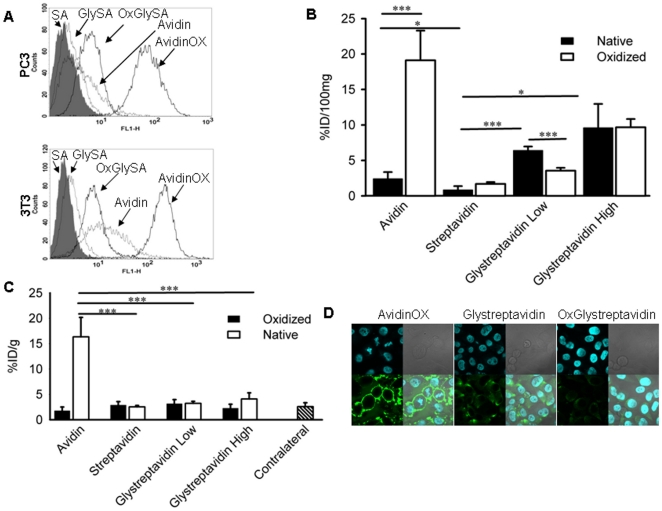

In vitro cell binding, in vivo tissue residence and biotin uptake of chemically glycosylated and oxidized streptavidin.
A, Binding of streptavidin (SA), low mannose streptavidin (GlySA) and oxidized derivative (OxGlySA) to human prostate carcinoma PC3 and mouse fibroblast NIH-3T3 cells was compared to avidin and AvidinOX. Cells were incubated with 150 µM of either native or oxidized glycoproteins at +4°C and binding revealed by cytofluorimetry with specific primary antibodies as detailed in Materials and Methods. Gray peaks represent background (second antibody, only). Thin and bold lines, native and oxidized glycoproteins, respectively. B, Avidin, streptavidin, low and high mannose streptavidin (corresponding to 26 and 60 % of mannosylated amino groups, respectively) were 125I-labeled and oxidized with sodium periodate as detailed in Materials and Methods. All samples in their native and oxidized form were diluted to 3.0 mg/ml in sodium acetate pH 5.5 and 15 µl were injected intramuscularly in one hind limb of mice. After 24 hours, the mice were sacrificed and treated limbs collected, muscle weighed and counted in a gamma counter. Data are expressed as the % of injected dose/100 mg (% ID/100 mg) of tissue. Each point is the average of 5 mice. Bars represent standard deviation. Statistical analysis was performed by Student's t test. ***p<0.001; *p<0.05. C, 111In-ST2210 was intravenously injected, 24 hours after the intramuscular administration of 15 µl of AvidinOX or indicated substances, at 3 mg/ml, in one hind limb of Balb/c mice. Mice were sacrificed after 2 hours and pre-treated and contra lateral limbs muscle (average from all treated groups) weighed and counted in a gamma counter. Data are expressed as the % of injected dose/g (% ID/g) of tissue. Each point is the average of 5 mice. Bars represent standard deviation. Statistical analysis by Student's t test. ***p<0.001. D, Confocal microscopy of PC3 cells incubated with the indicated products at 37°C as described in Materials and Methods. Mounting medium (Vectashield, Vector) containing DAPI (H-1200) was used to stain nuclei. Each panel shows DAPI stained nuclei (upper left), phase contrast image (upper right), staining with primary antibodies followed by second FITC-conjugated antibodies (lower left), merge of DAPI and avidin/streptavidin staining (lower right).